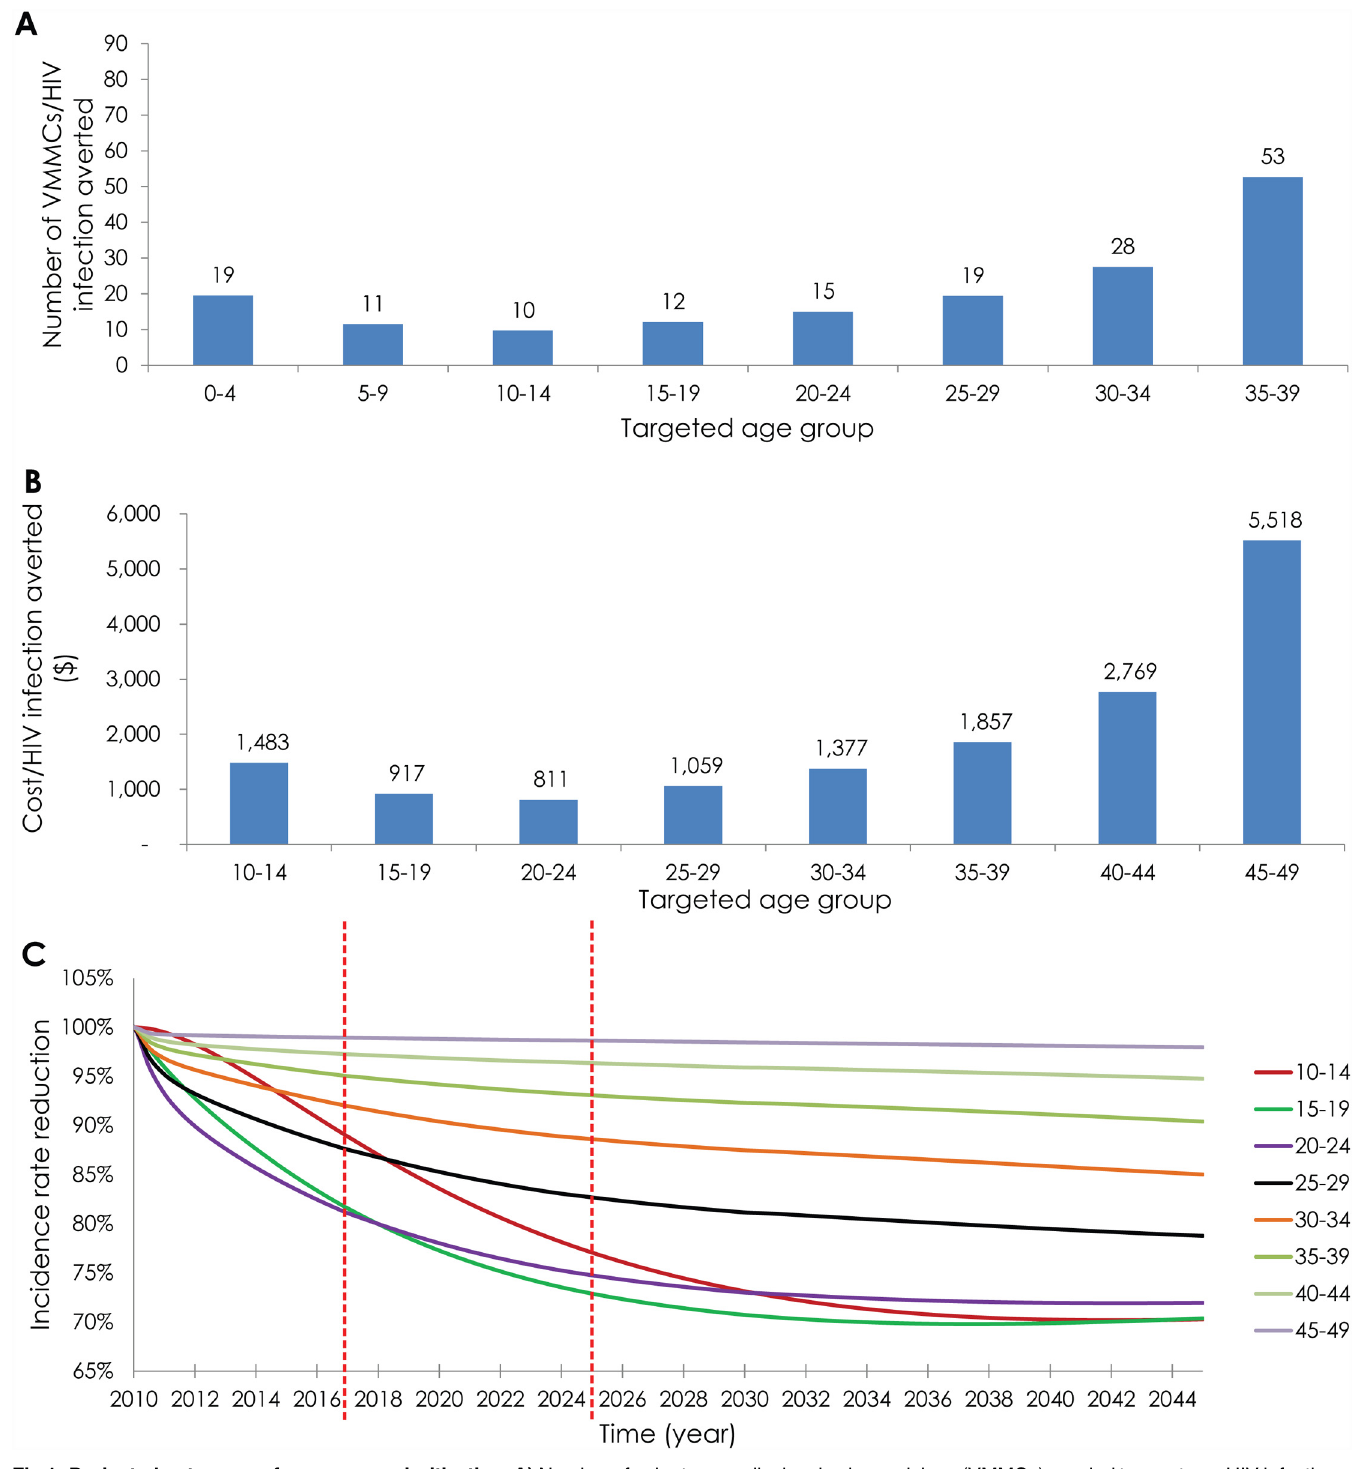
Fig 1. Projected outcomes of age-group prioritization. A) Number of voluntary medical male circumcisions (VMMCs) needed to avert one HIV infection ( effectiveness ) by 2025. B) Cost per HIV infection averted by 2025 ( cost-effectiveness ). C) Projected incidence rate reduction throughout the years up to 2045. The results are for 80% VMMC coverage by 2017 in each of the prioritized age band.